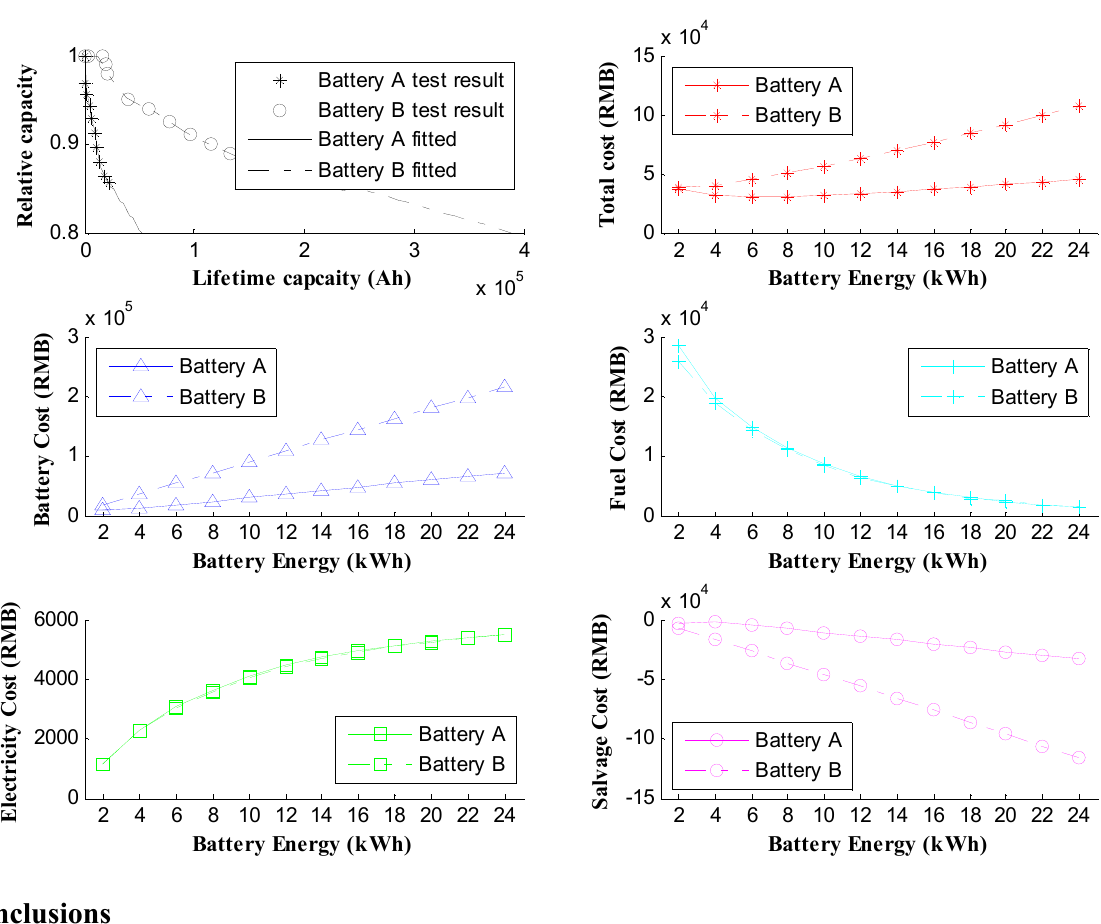
Figure 12. TCO comparison between battery